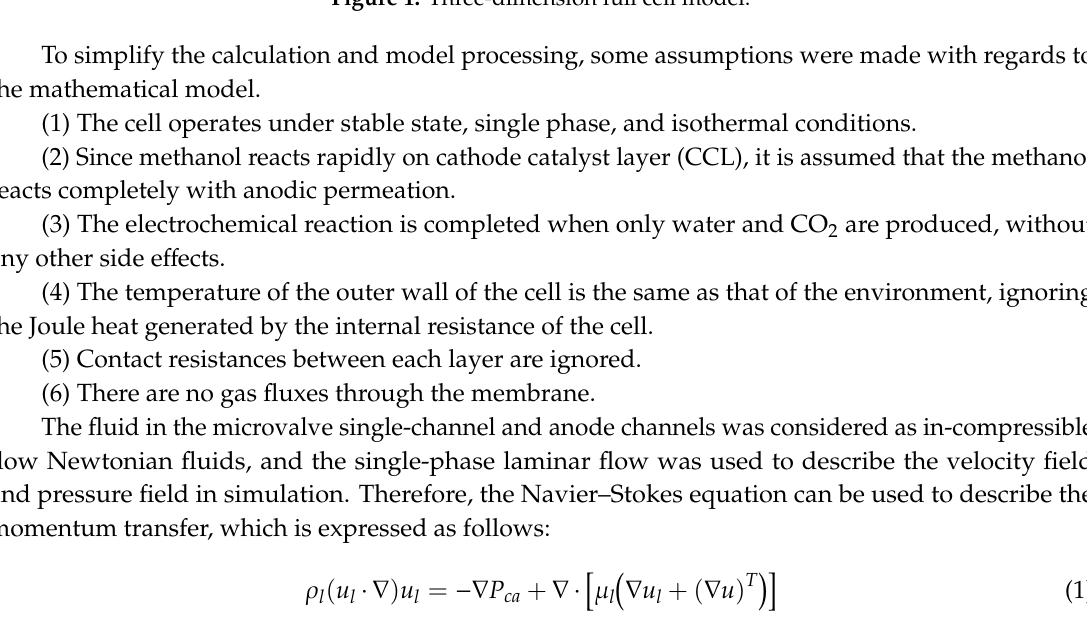
Figure 1. Three-dimension full cell model.